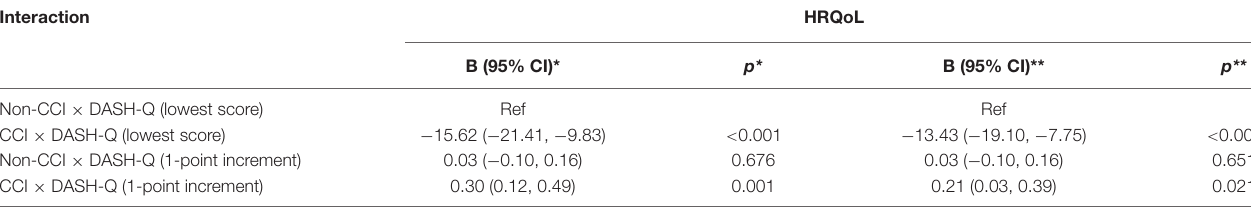
TABLE 3 | Interaction of comorbidity and diet quality on HRQoL among patients with stroke ( n = 951). Interaction HRQoL